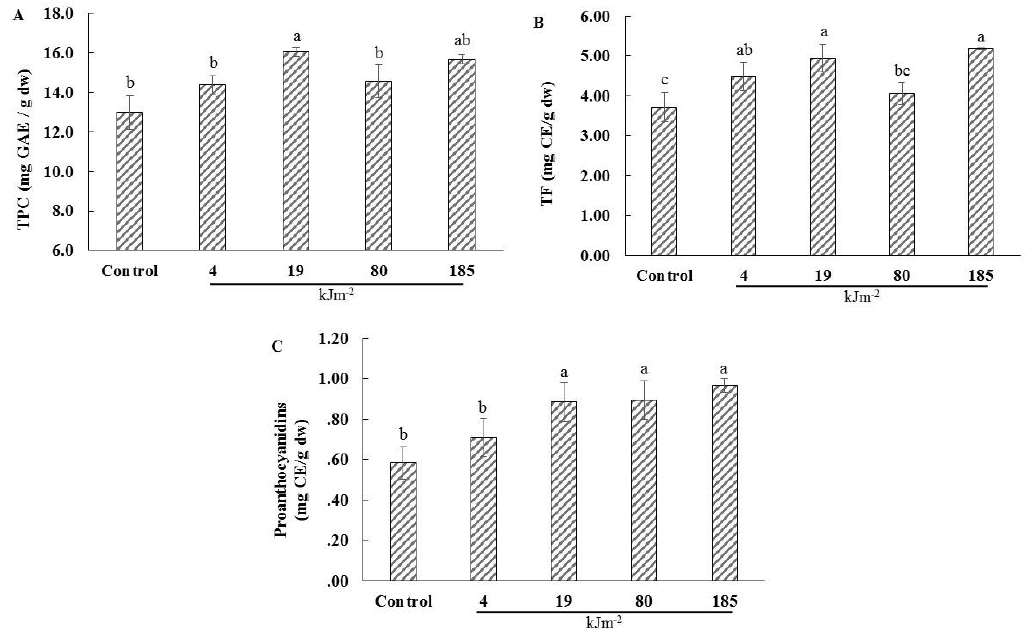
Figure 2. The effect of different UV-C irradiations on the total phenolic content (TPC) ( A ), total flavonoid content (TF) ( B ), and proanthocyanidins ( C ), of the aqueous lemon pomace extracts. The values are the mean of three replications. Data not sharing the same superscript letter are significantly different at p < 0.05.